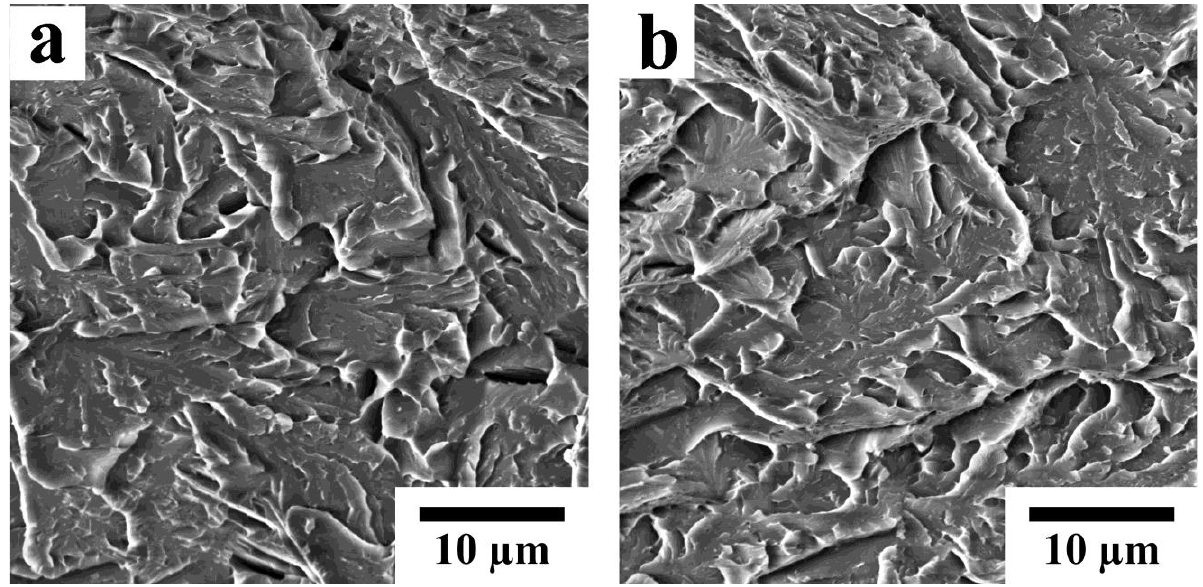
Figure 10. SEM images showing the fracture surface of the NT ( a ) and HR+Q ( b ) samples tempered at 500 °C. at 500 ◦